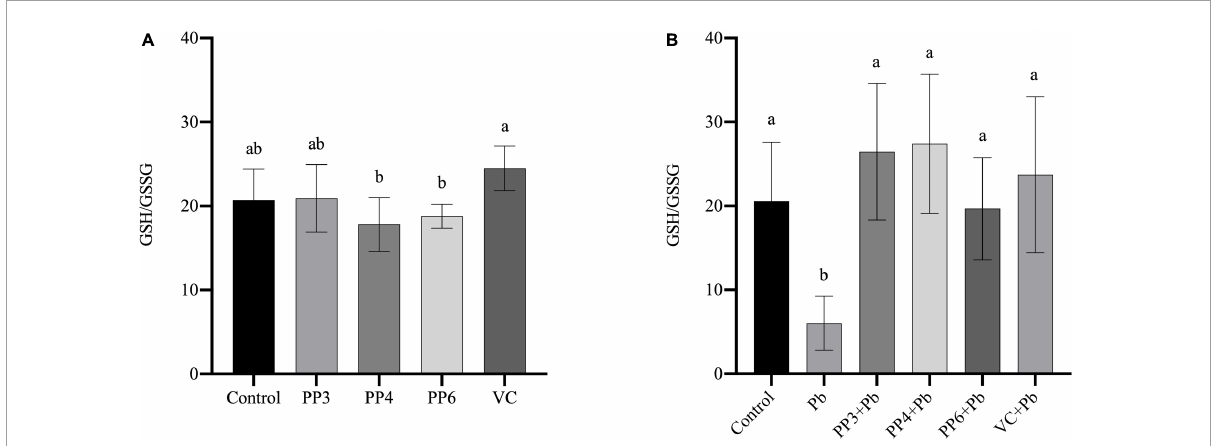
FIGURE4 Effect of PP3, PP4, PP6, and VC on GSH/GSSG in PC12 cells. (A) PC12 cells were incubated with PP3, PP4, PP6, and VC for 4 h. (B) PC12 cells were pre-incubated with PP3, PP4, PP6, and VC for 4 h, then treated with lead for 24 h. The valued of the bars indicates the means ± SD ( n = at least 3). Different superscript letters indicate differences ( P < 0.05).